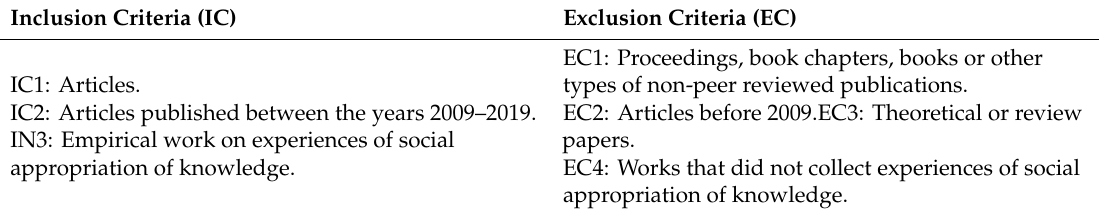
Table 2. Inclusion and exclusion